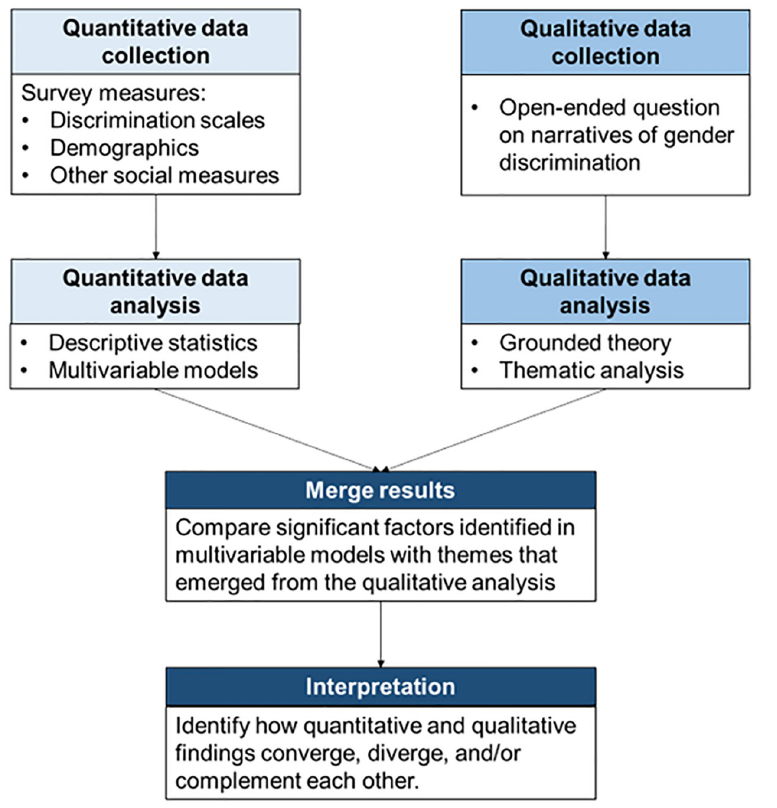
Fig 1. Mixed methods